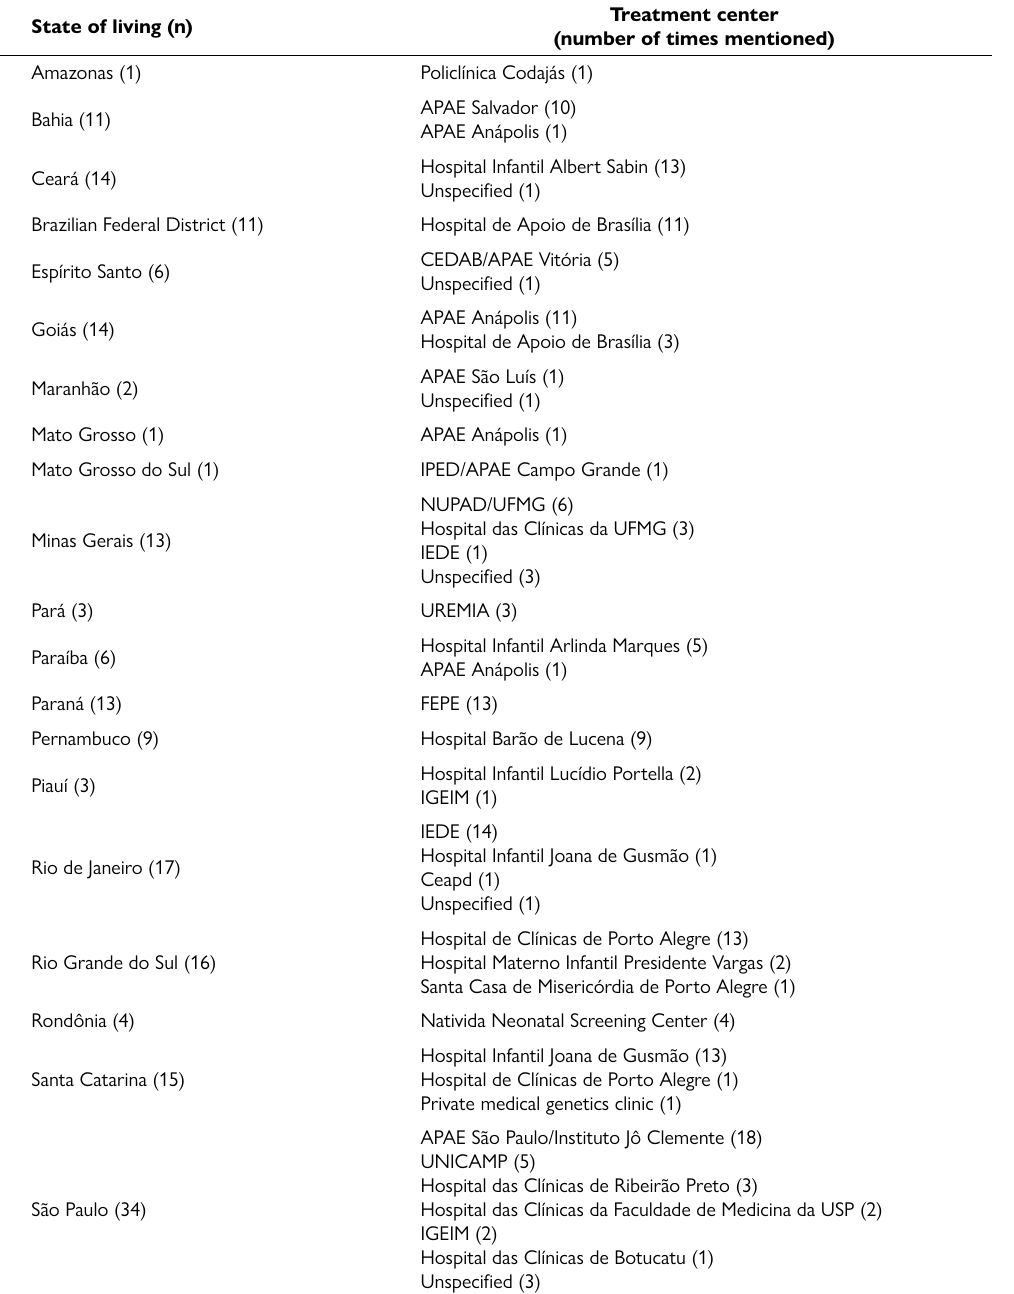
Table 1. PKU patients included in the study: Brazilian state of living and treatment